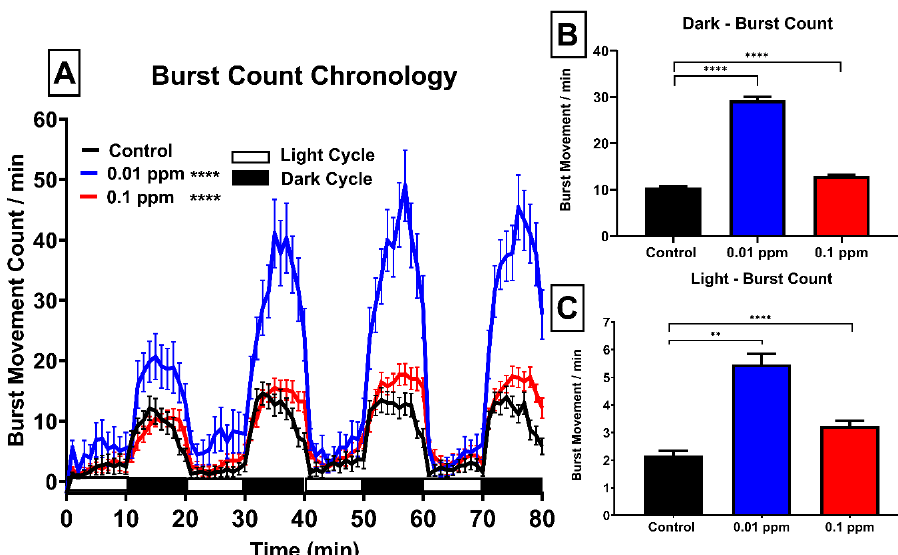
Figure 3. Total burst counts chronology of zebrafish larvae after exposure of Paclobutrazol. ( A ) Total burst movement in either light or dark phases of zebrafish larvae after treated with 0 (black color), 10 µg/L (0.01 ppm) (blue color) or 100 µg/L (0.1 ppm) (red color) ppm of Paclobutrazol. Quantitative comparison of burst movement in the light phase ( B ) or dark phase ( C ) for zebrafish larvae after exposure of Paclobutrazol. The data are expressed as the means ± S.E.M. and analyzed by the One-way ANOVA with the Geisser–Greenhouse correction (** p < 0.01, **** p < 0.0001).